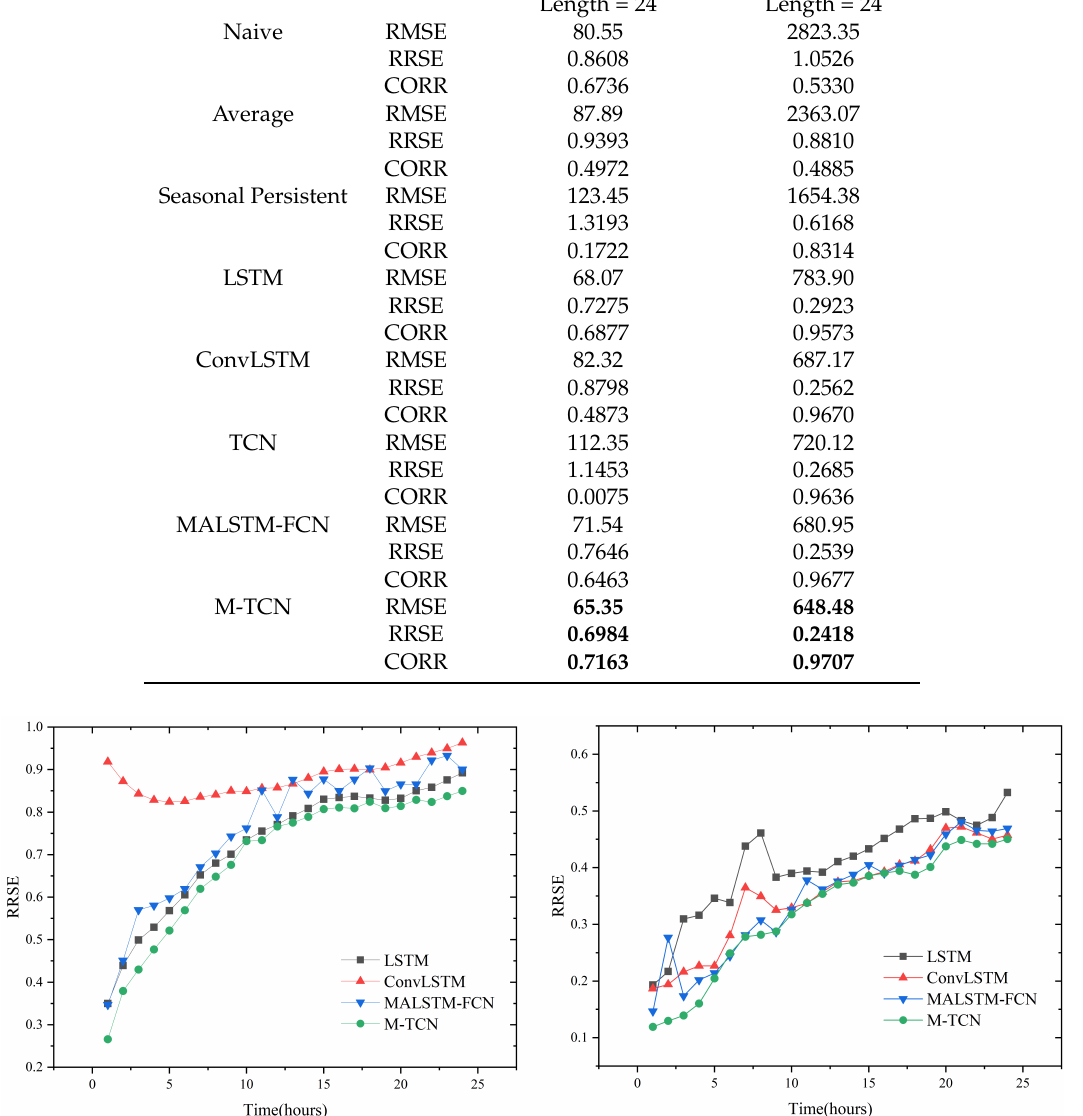
Figure 9. The RMSE for each lead time from hour 1 to hour 24 vs. different algorithms over Beijing PM2.5 ( left ) and ISO-NE Dataset Dataset ( right